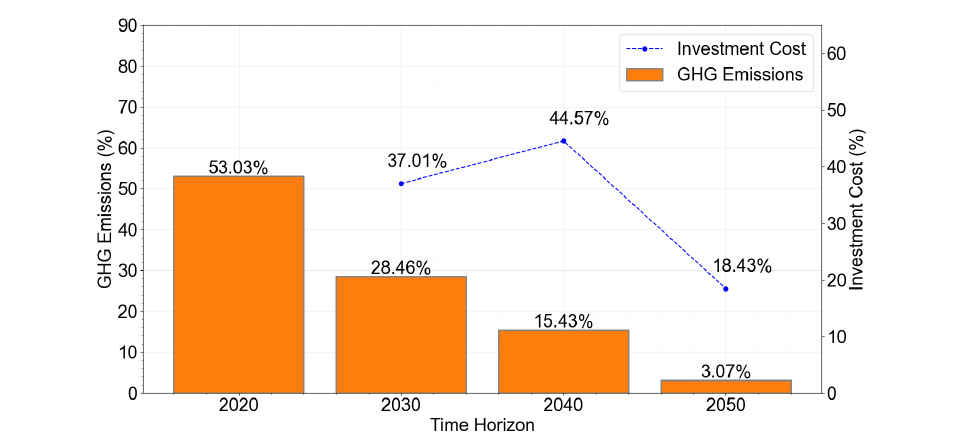
Figure 13. Alternative 3—Comparison between emissions and the investment cost for the Service